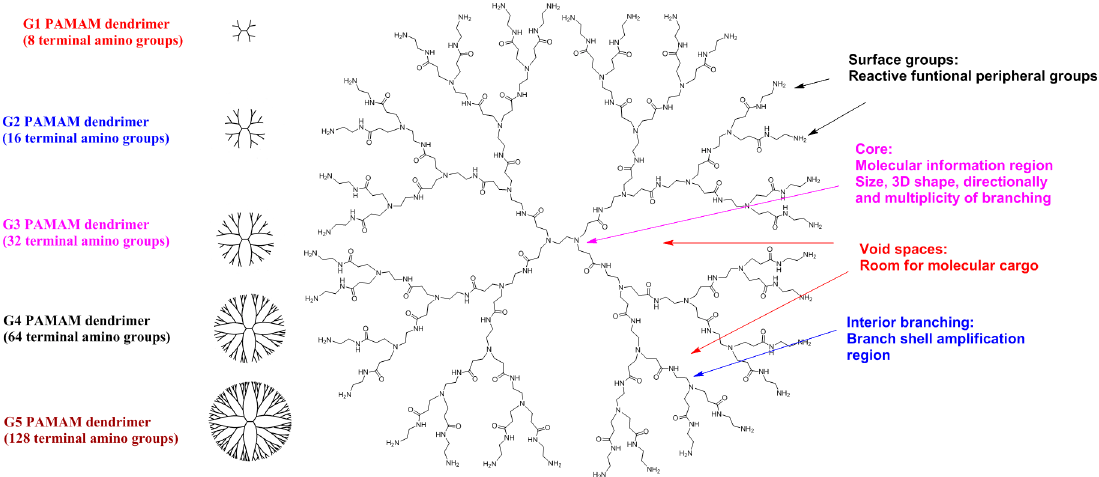
Figure 3. Schematic 2D representation of G3 PAMAM dendrimer as a typical dendritic structure.